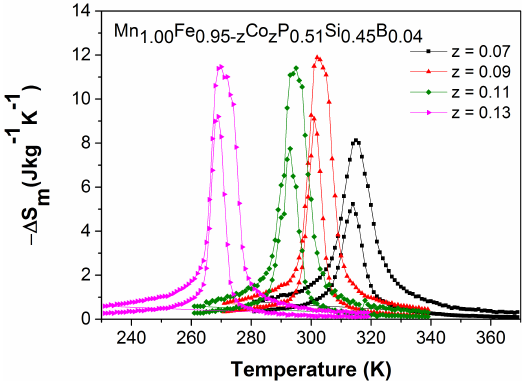
Figure 9. Magnetic entropy change as a function of temperature for a field change of 1 T (lower curve) and 2 T (upper curve) derived from isofield M B (T) curves measured upon cooling in the vicinity of T C